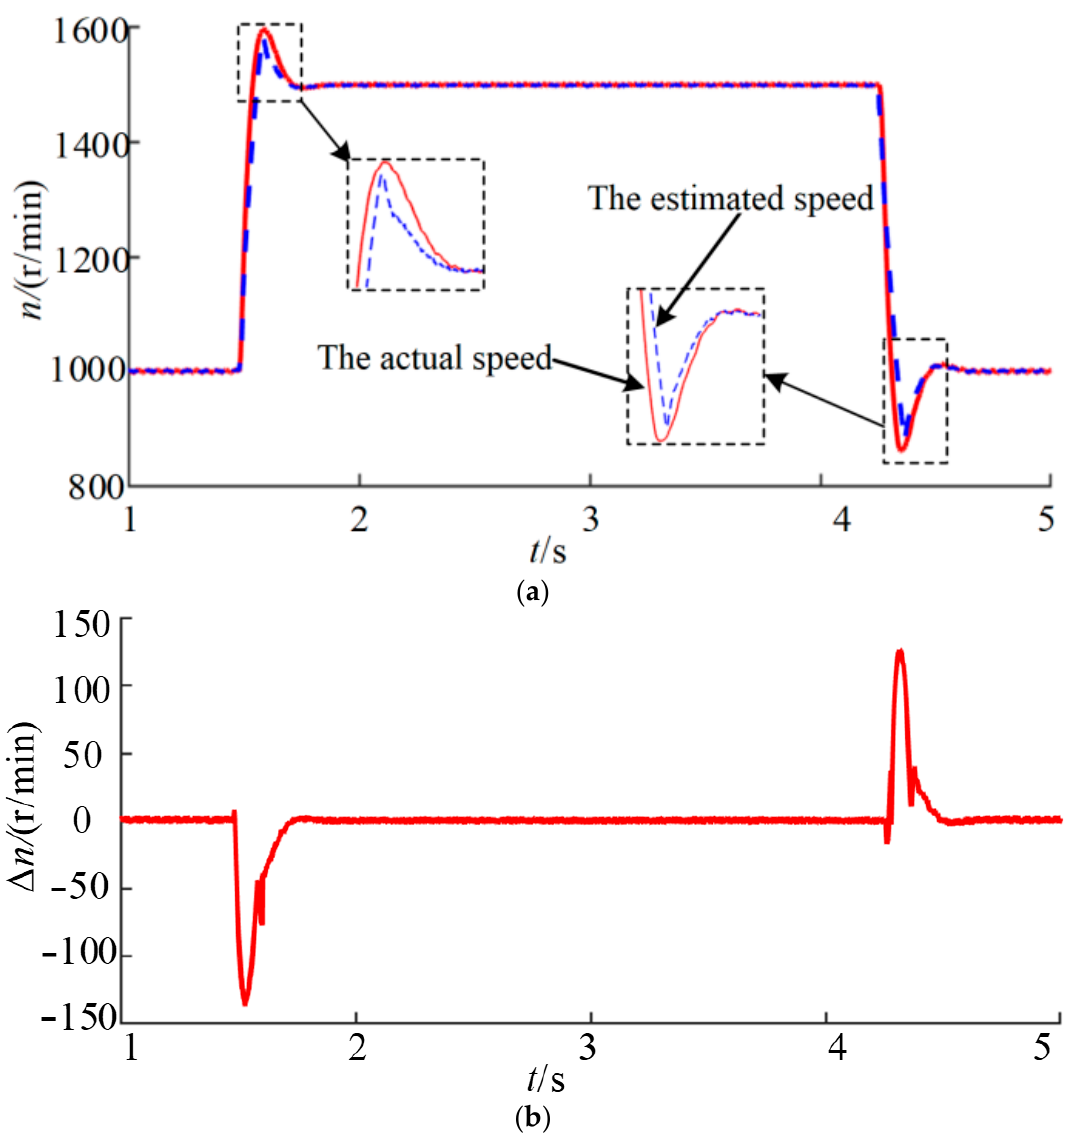
Figure 7. Distributions of the speed mutation. ( a ) Experimental curve of the speed. ( b ) Experimental curve of the rotational speed error.